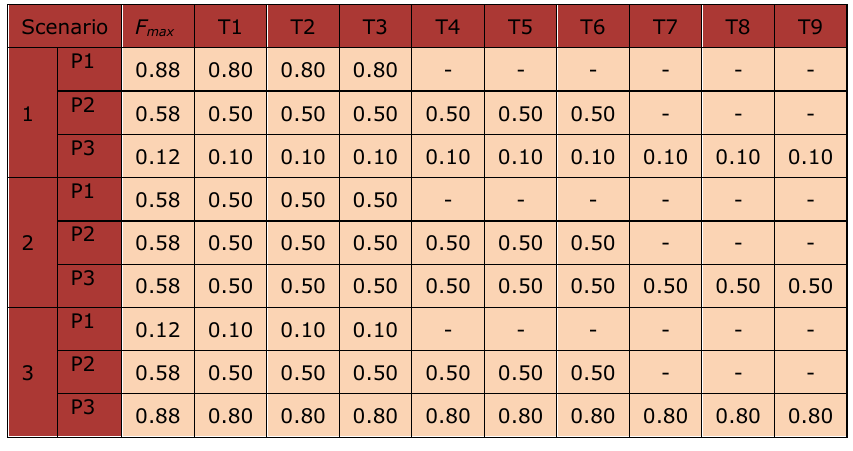
Table 12. Different Scenarios with Different Load Levels (  =1.3  =0.215)